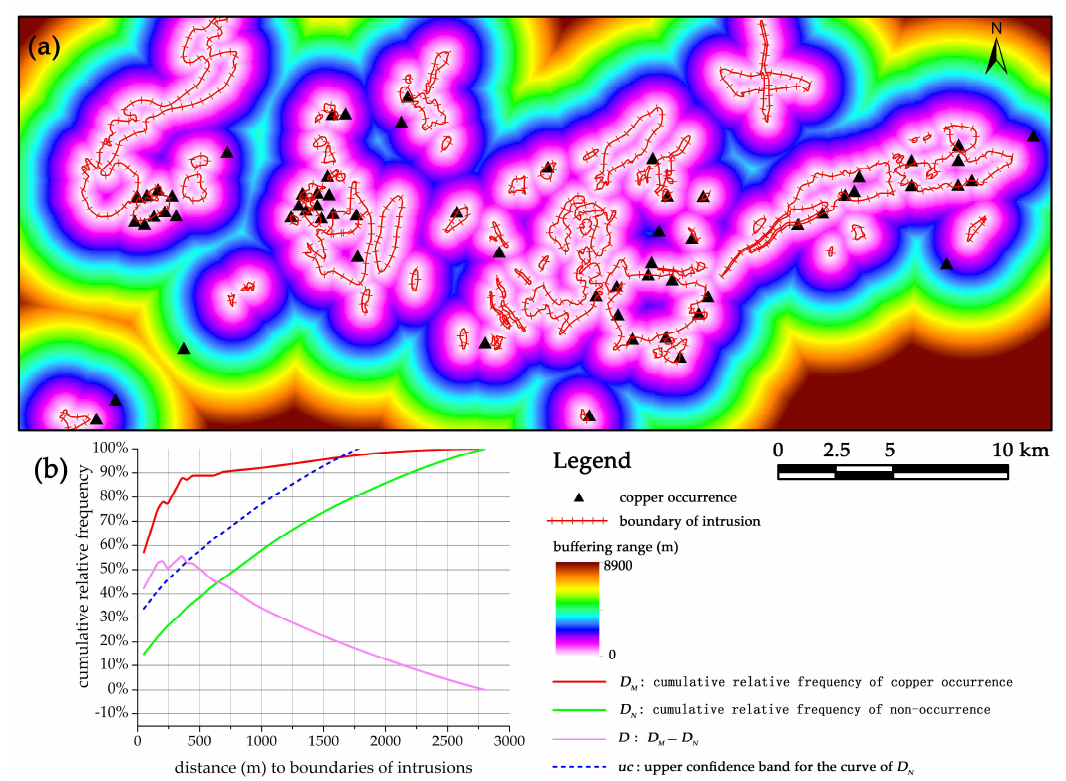
Figure 14. ( a ) Buffer analysis and ( b ) graph of cumulative relative frequency concerning distance to boundaries of intrusions.